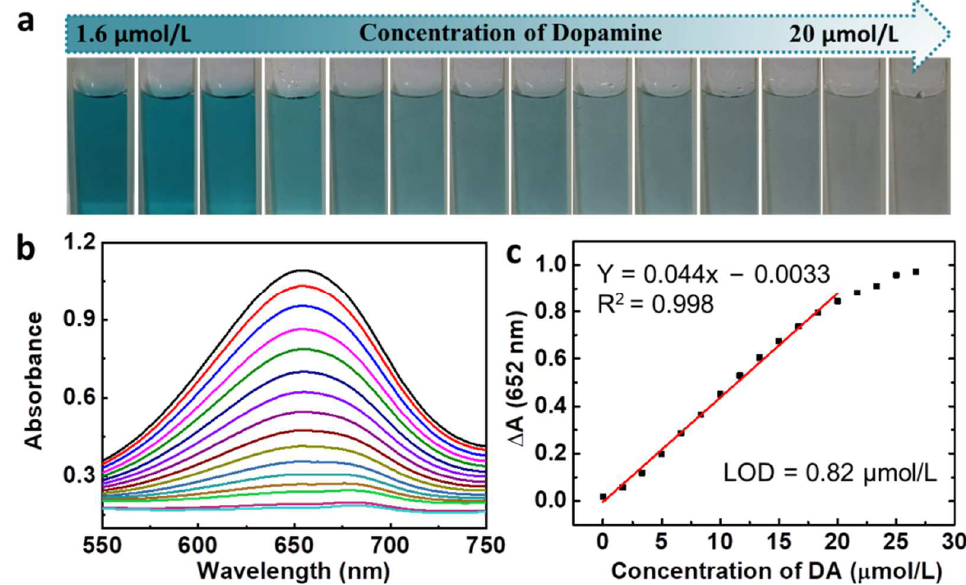
Figure 5. ( a ) Visual color changes of TMB-buffer-Co 3 O 4 -200 with the increase of the concentration of dopamine, ( b ) the corresponding UV-vis absorption spectra, and ( c ) the plots of the net absorbance ( Δ A) with the concentration of dopamine.